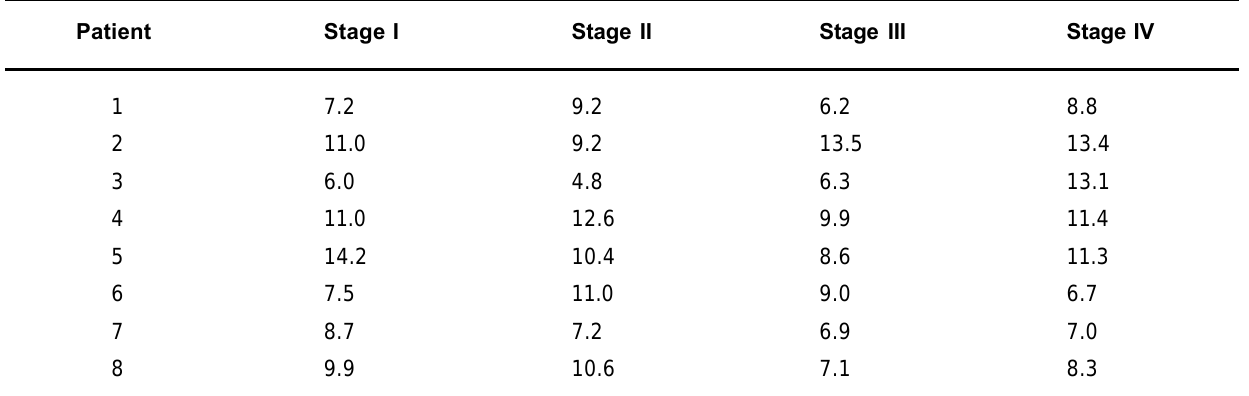
TABLE 8 - Mean vertical mandibular movement during chewing (in